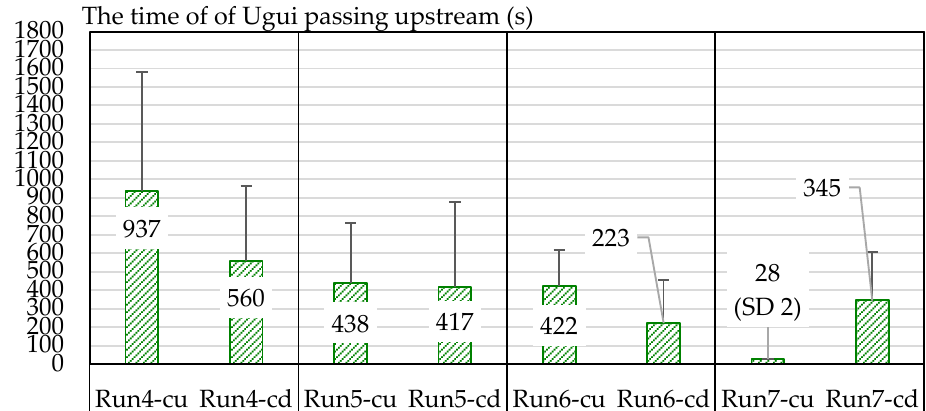
Figure 17. The average time of Ugui passing upstream that successfully moved upstream in each case (Run4-cu and Run4-cd are previous study [4]).